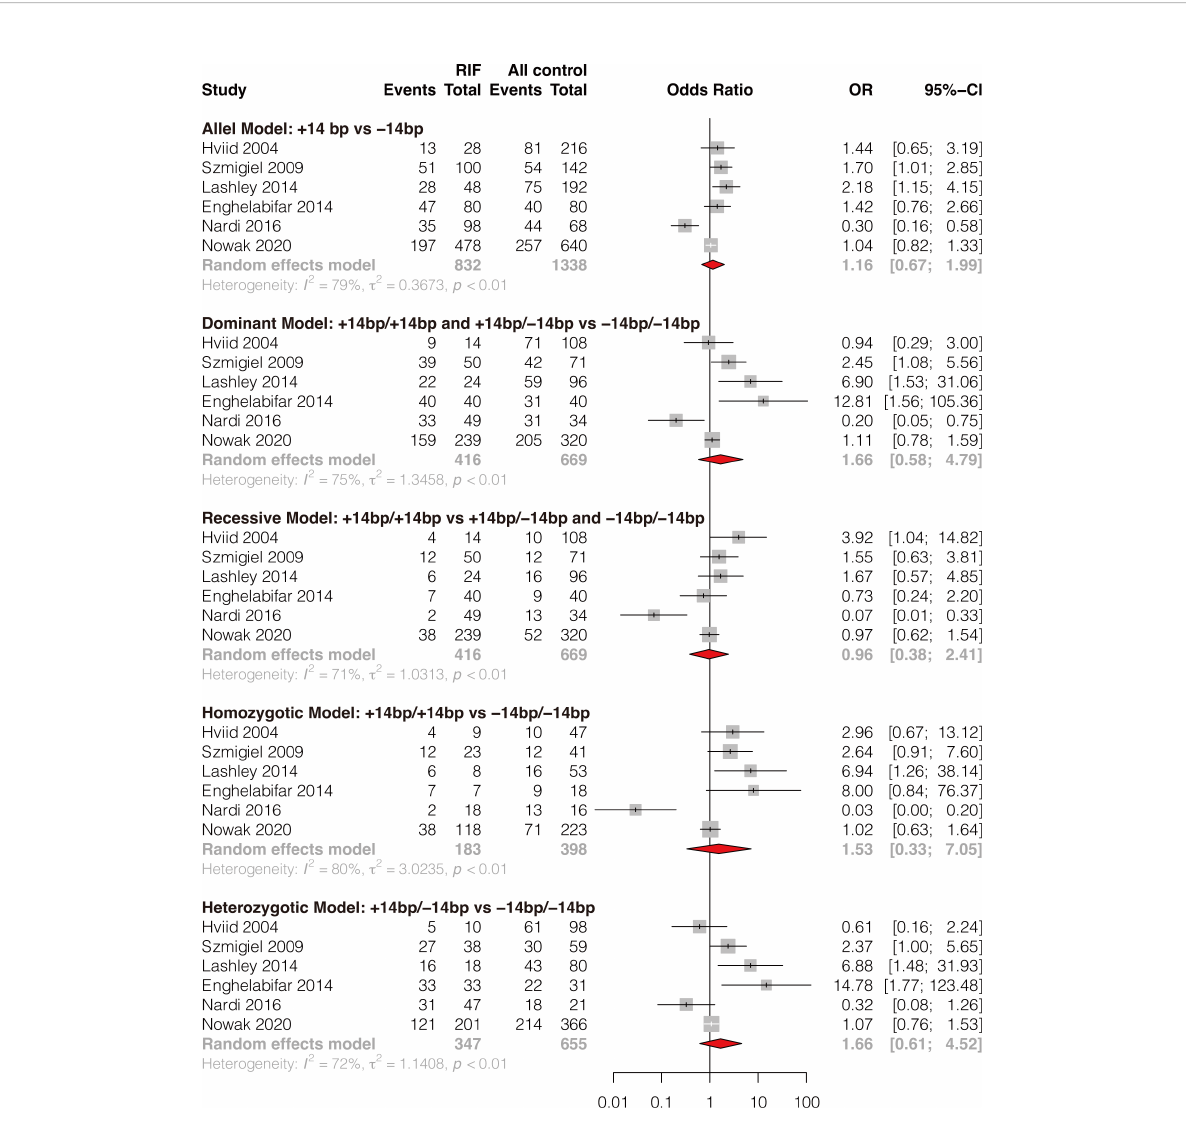
FIGURE 2 Forest plot showing the association of HLA-G 14bp ins/del polymorphism with RIF under 5 genetic